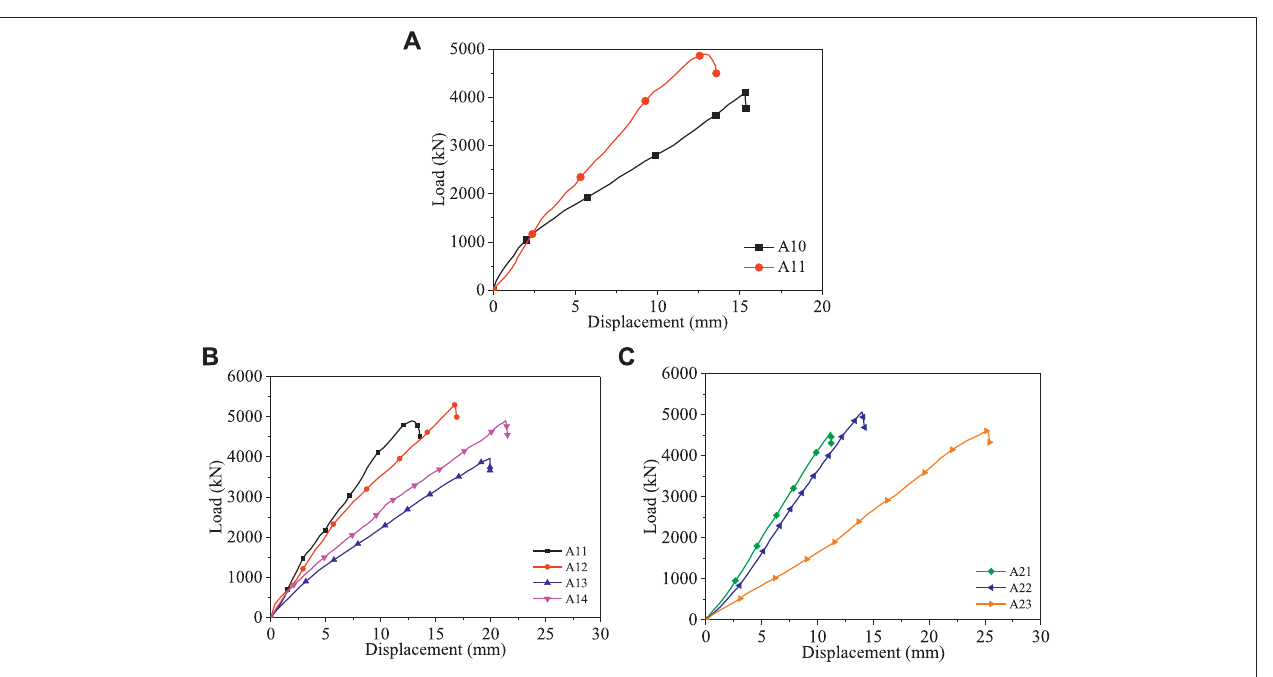
Frontiers in Built Environment |